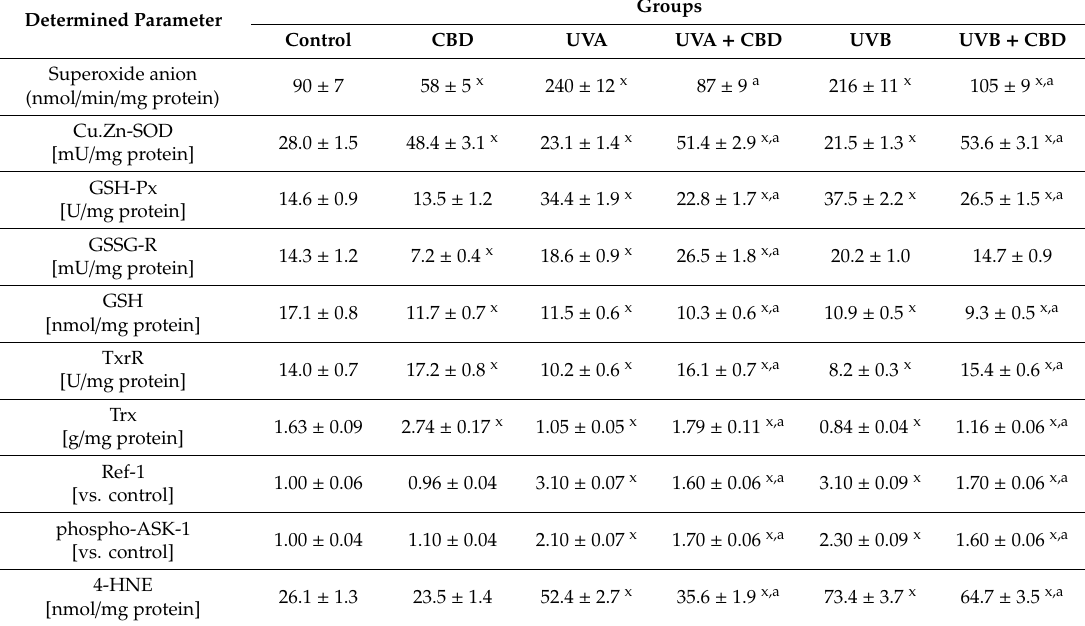
Table 1. The influence of cannabidiol (CBD) on ROS generation (by ESR) and antioxidant capacity estimatedasprotein(Cu,Zn-SOD,GSH-Px, GSSG-R,TrxRbyspectrometry)andnon-proteinantioxidants (GSH by CE, Trx by Elisa, Ref-1 and phospho-ASK-1 by Western blotting) as well as lipid peroxidation (4-HNE by GCMS) of keratinocytes exposed to UVA (30 J / cm 2 ) and UVB (60 mJ / cm 2 ) irradiation. Groups Determined Parameter Control CBD UVA UVA + CBD Superoxide anion 90 ± 7 (nmol / min / mg protein)